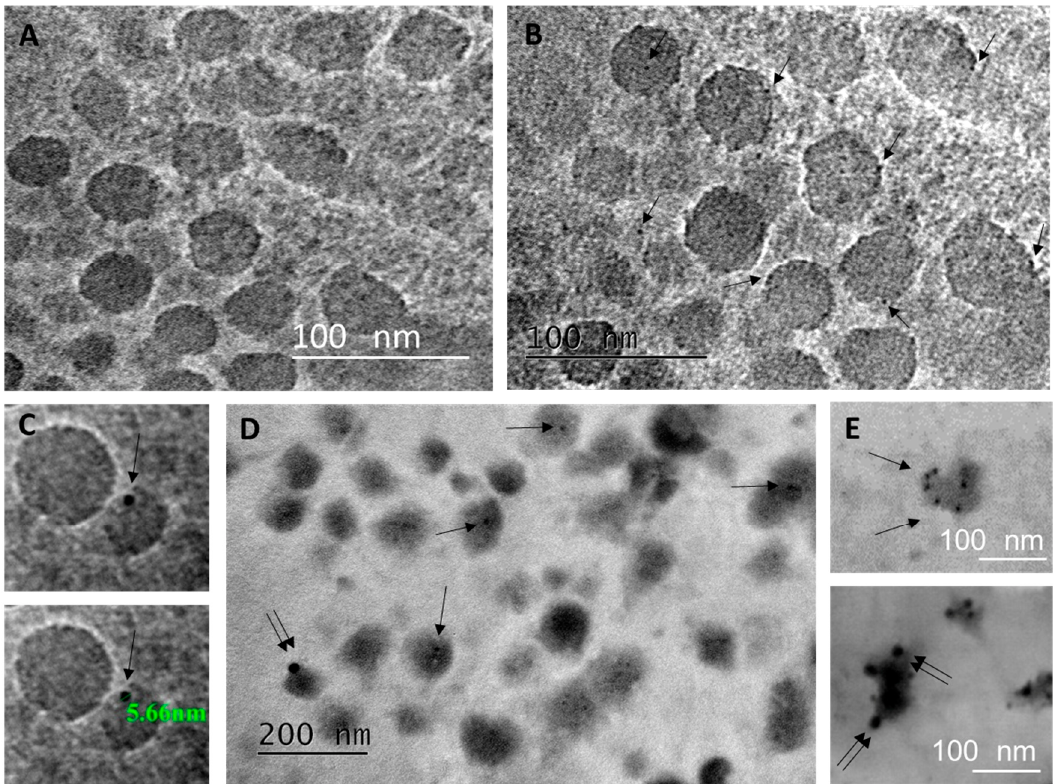
Figure 4. Immunogold electron microscopy of crude small EV pellet from one early ARDS patient’s BAL fluid by the whole mount method. ( A – C ) The EV pellet was applied on thin carbon-coated grids, fixed with 4% paraformaldehyde, blocked with BSA 3%, stained with anti-CD63 (in mouse) and detected with anti-mouse IgGs conjugated with 5 nm gold particles and Uranyl Acetate (UA). ( A ) Negative control to show the specificity of the secondary Ab (working dilution of the gold particles; BSA instead of anti-CD63). ( B ) The small EV pellet was positively labeled with the CD63-specific gold particles (arrows). (C) Higher magnification to show the size of the gold particles used. ( D , E ) Double immunodetection of sPLA 2 -IIA (anti-Rb IgGs 15 nm gold) in the CD63-positive (anti-Mo IgGs 5nm gold) exosome pellet after saponin permeabilization of the lipid bilayer. CD63-positive EVs (5 nm, single arrows) were detected in the vicinity of sPLA 2 -positive EVs (15 nm, double arrows). ( E ) Higher magnification of individual EVs showing heavy decoration with CD63 or sPLA 2 -specific gold particles.